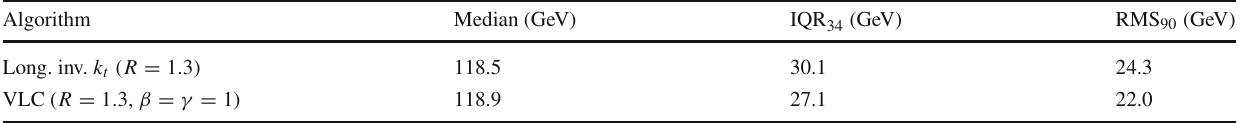
Fig. 11 The reconstructed di-jet mass distribution for fully hadronic decays of e + e − → ν ¯ ν hh , h → b ¯ b events at a 3 TeV CLIC. In the left panel all Higgs boson candidates are included, in the right panel only those that match onto exactly two b-quarks from Higgs boson decay. The nominal level of γγ → hadrons background is overlaid on the signal. Particle-flow objects are selected using the tight selection